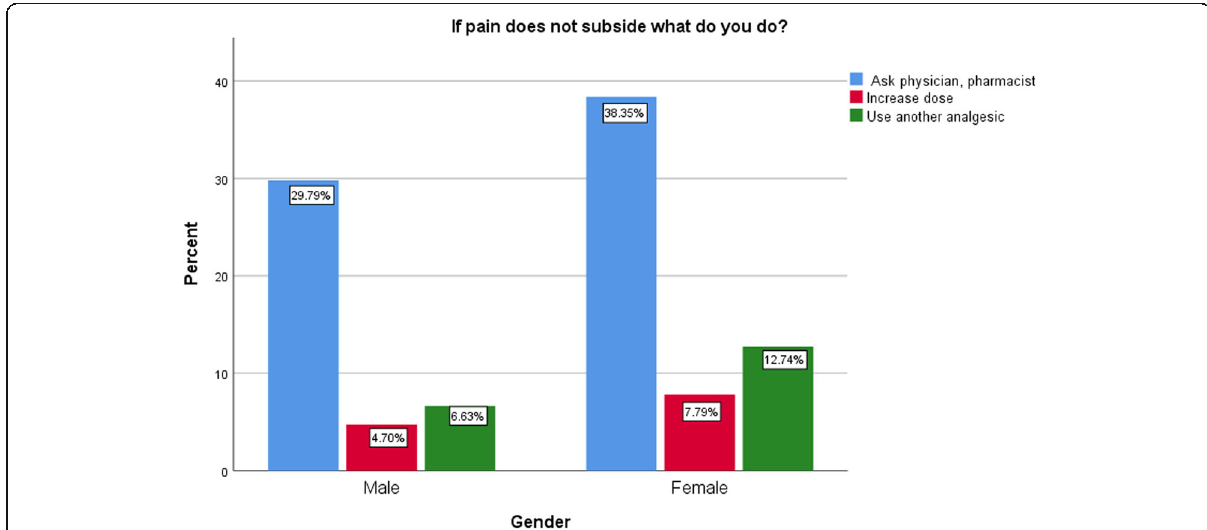
Fig. 2 The percentage of gender by if the pain did not subside, what do you